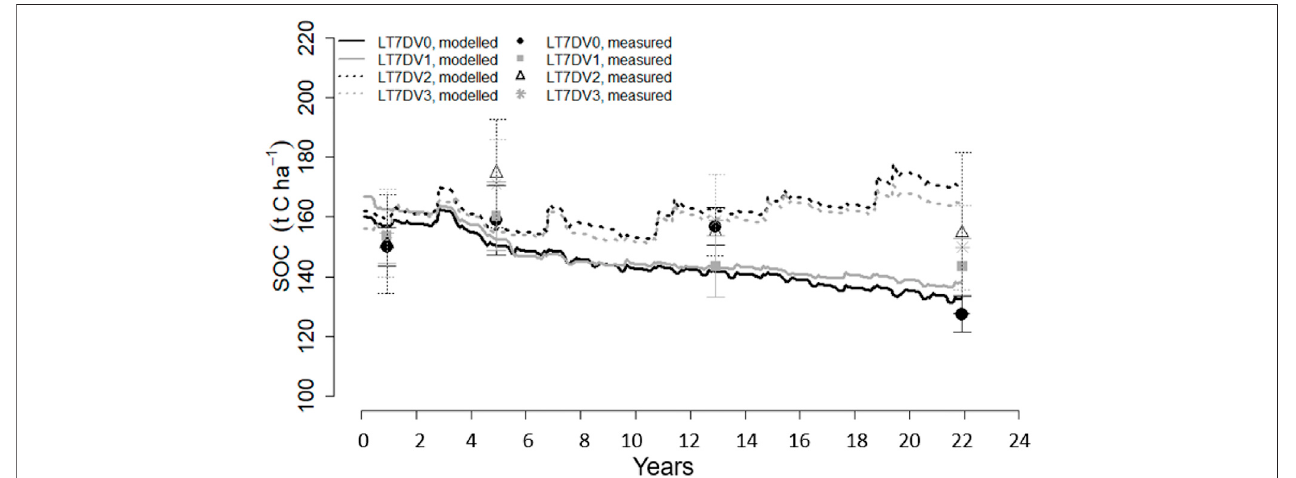
FIGURE 6 | Measured (point) and modeled (line) SOC under conventional (LT7DV0), diversi fi cation 1 (LT7DV1), diversi fi cation 2 (LT7DV2), and diversi fi cation 3 (LT7DV3) management in Toholampi (Finland) fodder cropland site, LT7, for the period 2010 – 2018 at 0 – 30 cm depth. The error bar indicates standard deviation of the measured SOC.